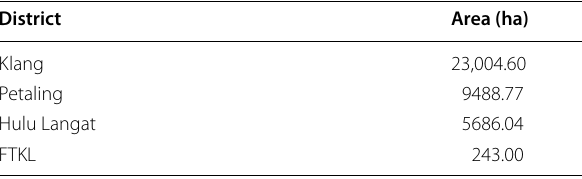
Table 1 Districts and area (ha) in the Klang